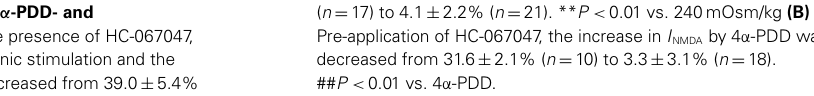
(100 µ M) decreased I NMDA from -25.01 ± 5.95 to -18.19 ± 2.50 pA/pF ( n = 7, paired t -test, P < 0.01), and from -24.94 ± 1.49 to -17.16 ± 1.57 pA/pF ( n = 7, paired t -test, P < 0.01),